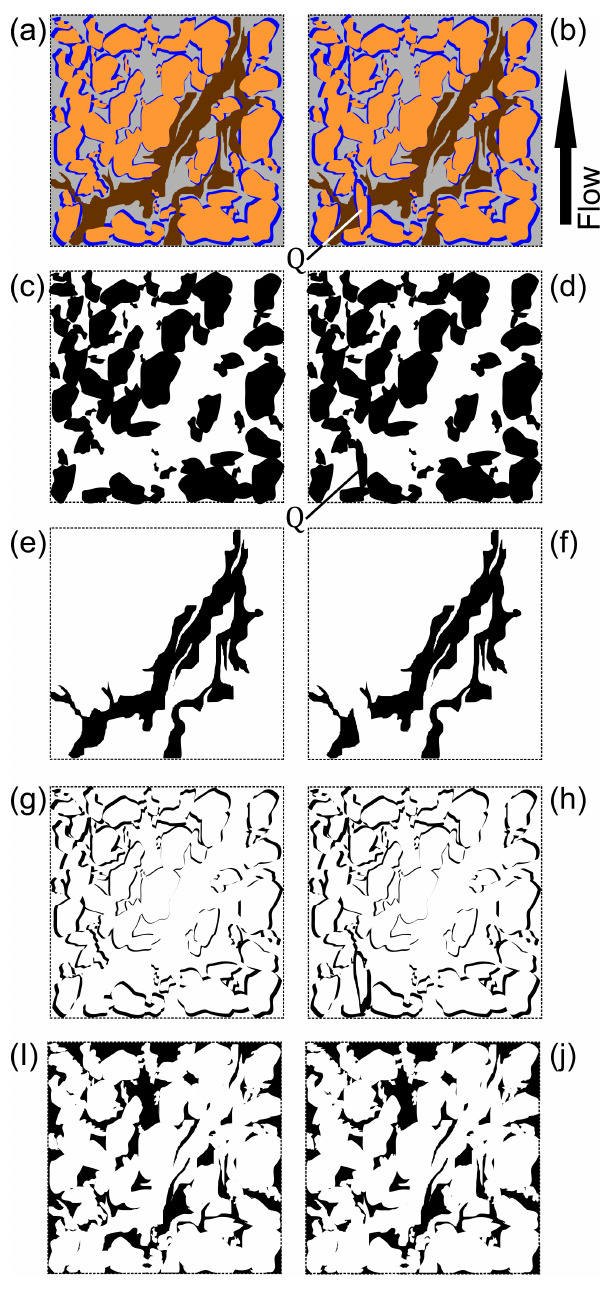
Figure 1. Distribution of a four-phase clay-rich, water-wet sand- stone saturated with water and oil (quartz – orange; clay – brown; water – blue; oil – grey) represented by a 2-D slice through a 3-D medium. The left-hand column differs from the right-hand column by the addition of a single grain of quartz with its associated surface water, labelled Q. Consequently, the figure should be read vertically comparing the two columns: (a, b) complete medium; (c, d) quartz distribution; (e, f) clay distribution; (g, h) water distribution; and (i, j) oil